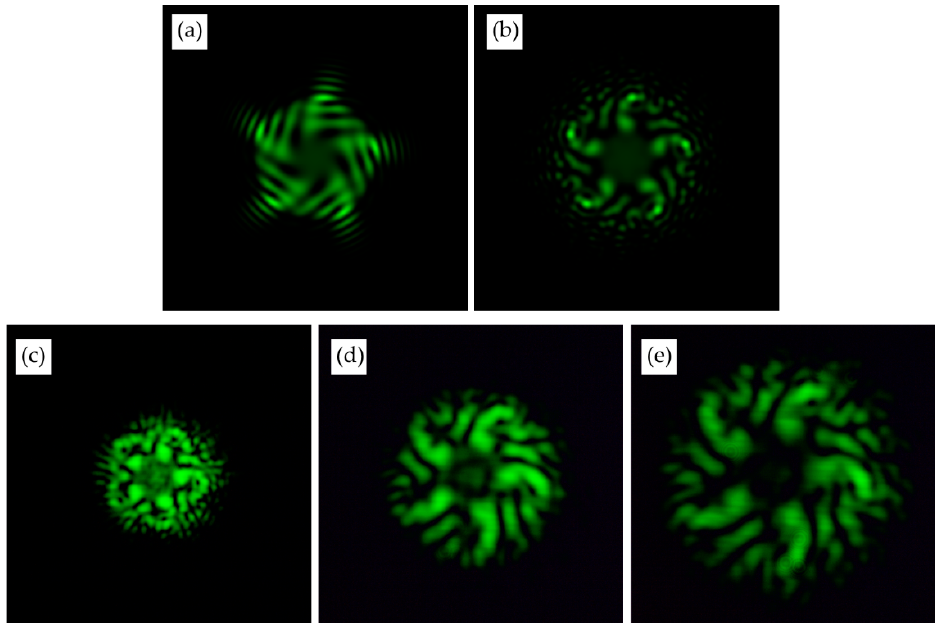
Figure 7. The intensity distribution of the field (33) with n = 3, k = 0, m = 5, a = 1, w 0 = 500 μ m, computed at a distance 147 mm from the initial plane ( a ), the intensity distribution computed at the same distance but only from the phase of the field (33) (Figure 6) ( b ), and the experimental intensity obtained by the SLM in an optical setup from Figure 5 with the phase from Figure 6b at the different distances from the lens L 2 : 50 mm ( c ), 100 mm ( d ), 150 mm ( e ). All figures are 5 × 5 mm.